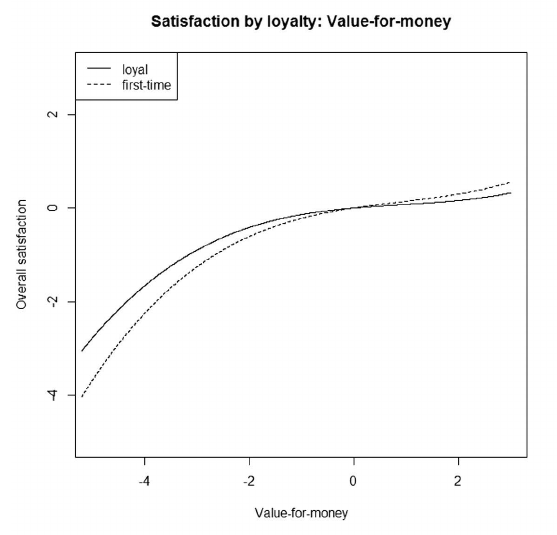
Figure 8. Ski Core in two loyalty groups Figure 9. Ski Peripherals in two loyalty groups